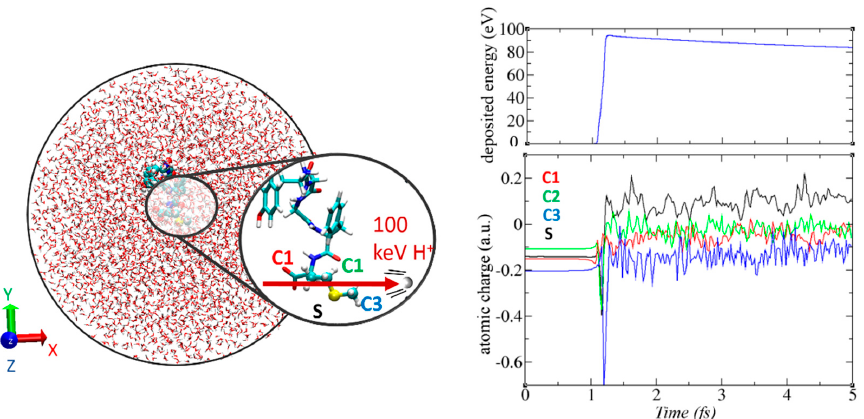
Figure 12. Collision of terminal methionine residue by a 100 keV proton. Left: QM / MM set-up. Only methionine residue is treated as QM (balls and sticks), the rest of the system pertains to the MM region. Right: Variation of QM / MM energy of the system and charges of the carbon and sulfur atoms region.